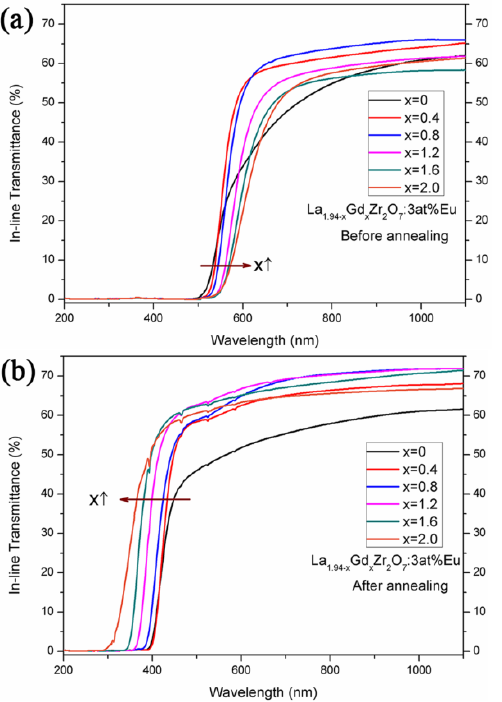
Fig. 17 Transmittance of La 1.94– x Gd x Zr 2 O 7 :3at%Eu 3+ ( x = 0–2.0) transparent ceramics (a) before and (b) after annealing. Reproduced with permission from Ref. [53], © John Wiley and Sons 2015.